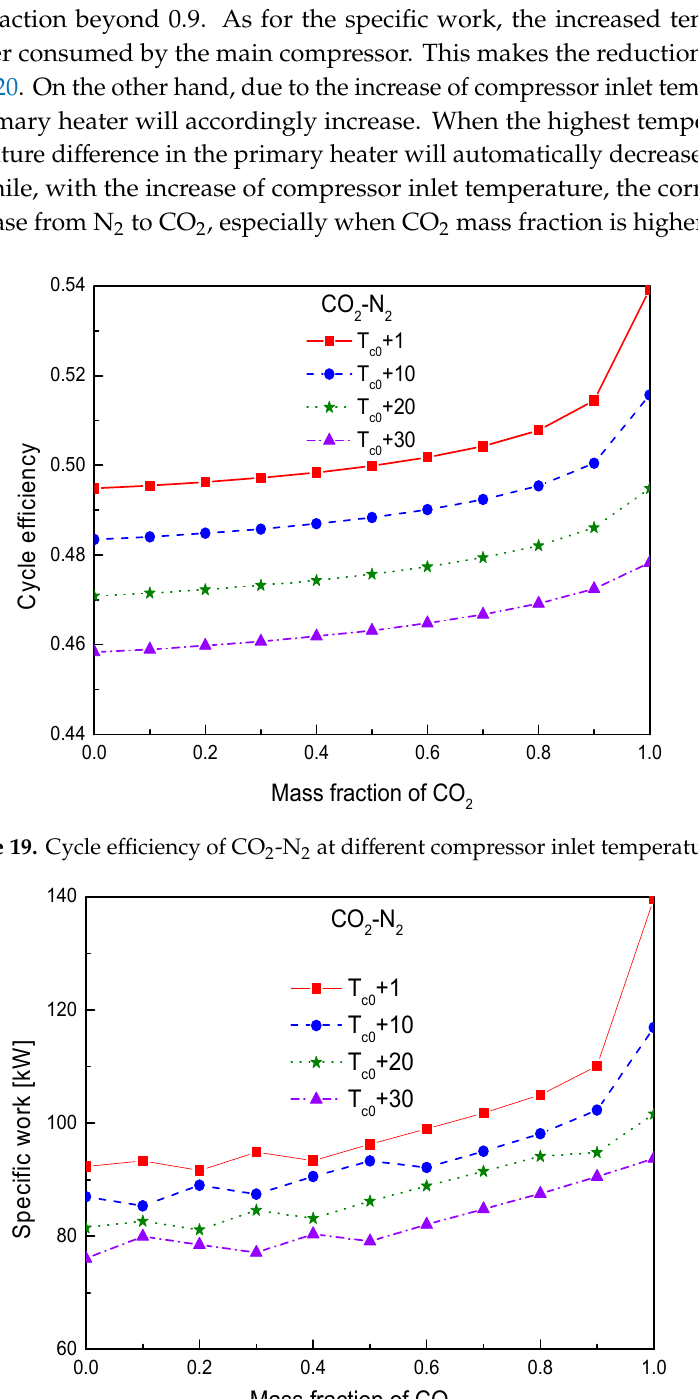
Figure 20. Specific work of CO 2 -N 2 at different compressor inlet temperatures.